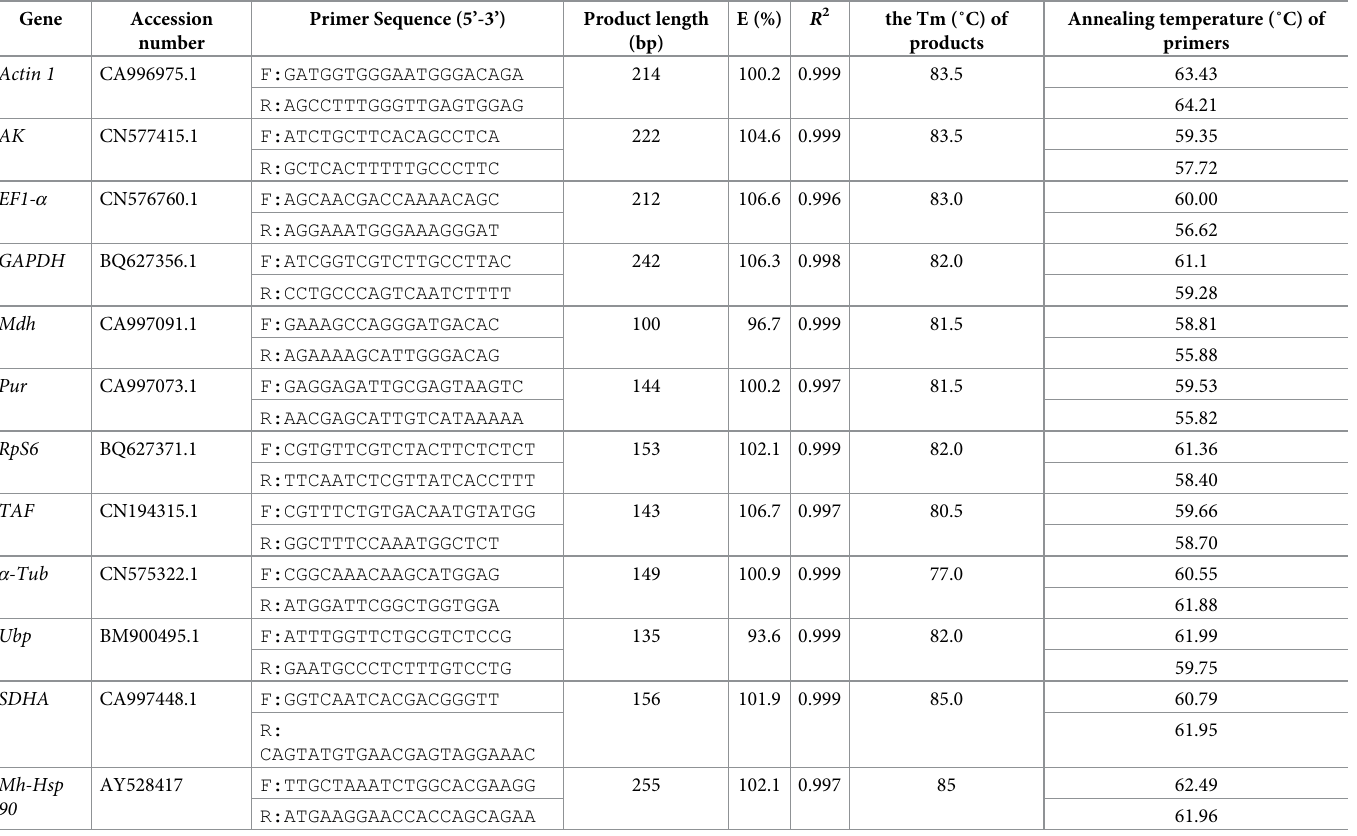
Table 1. Details and primer sequences of candidate reference genes and target gene used in